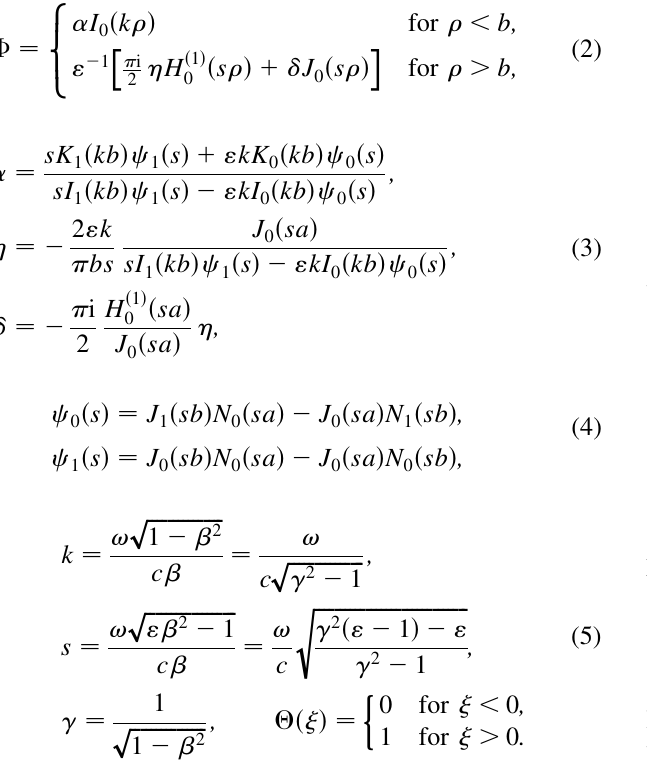
p ffiffiffiffiffiffiffiffiffiffiffiffiffiffiffi c (cid:1) 2 (cid:1) 1